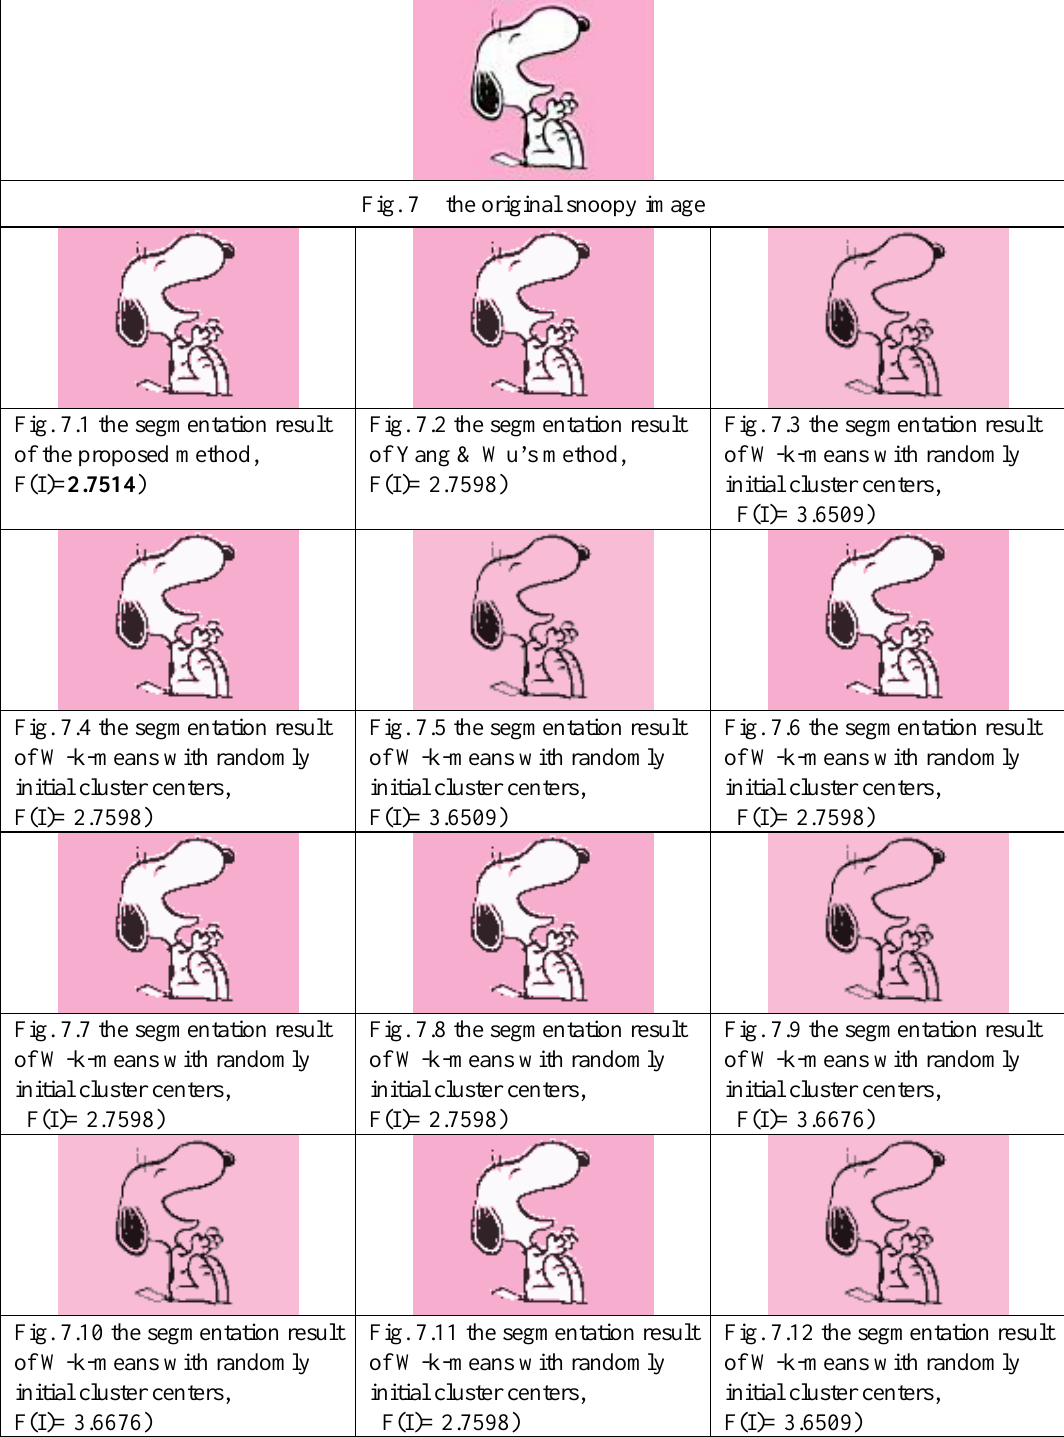
Fig. 7.11 the segmentation result Fig. 7.12 the segmentation